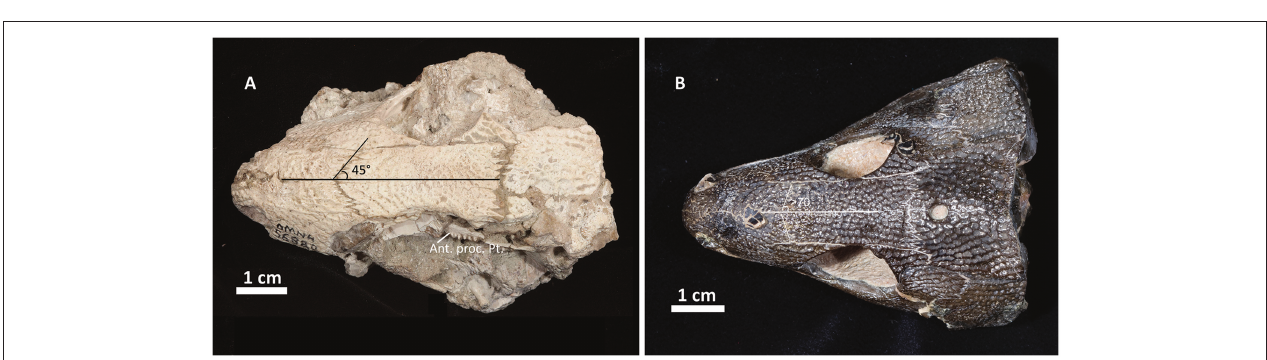
FIGURE 7 | Comparison of the skull table between Captorhinus magnus (A) and Captorhinus kierani (B) . Note how the angle formed between the nasals and frontals is much more acute in the former.